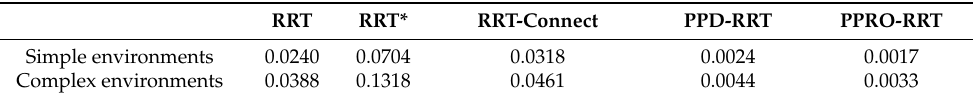
Table 3 indicates the path planning time of different algorithms in two kinds of experi- mental environments. For each of the proposed algorithms, the path planning time was ment, the path planning time of the PPD-RRT and PPRO-RRT algorithms was 90%